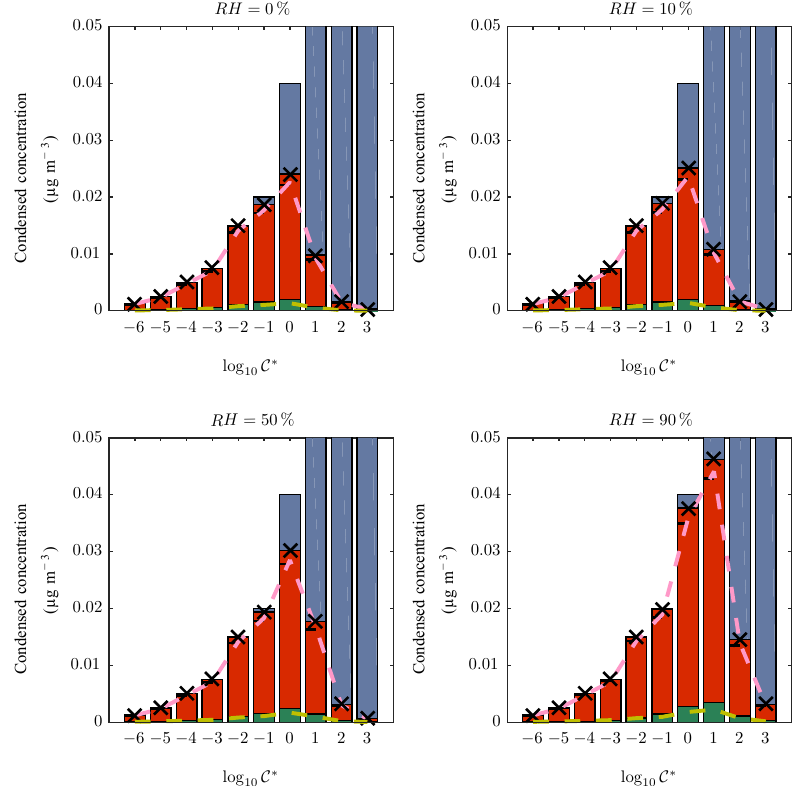
3] Figure 11. Same as Fig. 9 for involatile aerosol modes represented by lognormal size distributions with number concentrations of 200 and 50cm − 3 and median diameters of 25 and 125nm, respectively. The geometric standard deviations are 0.5 and 0.1. The relative humidity used in each simulation is stated above each plot.